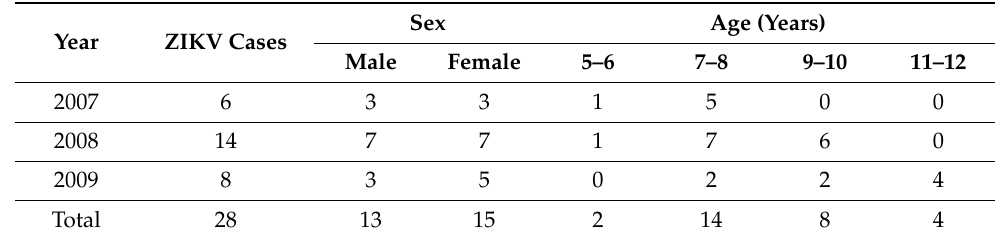
Table 2. Characteristics of ZIKV cases.